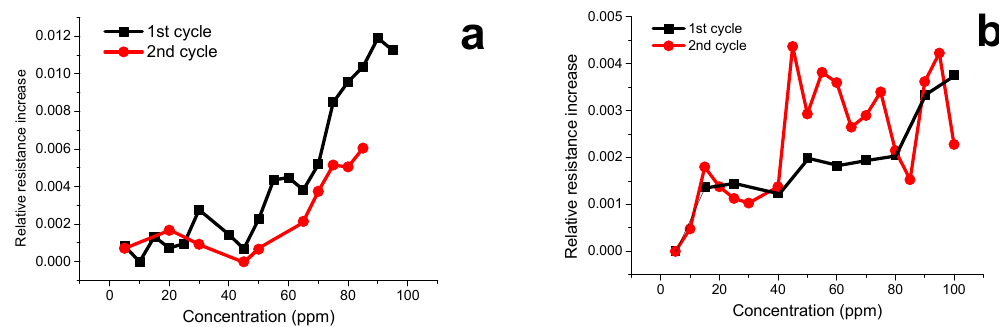
Figure 10. Relative resistance variation (%) of 7 wt.% MWCNTs/TP9PYR(6) dispersion as a function of ( a ) CHCl 3 and ( b ) THF vapours concentration (ppm).